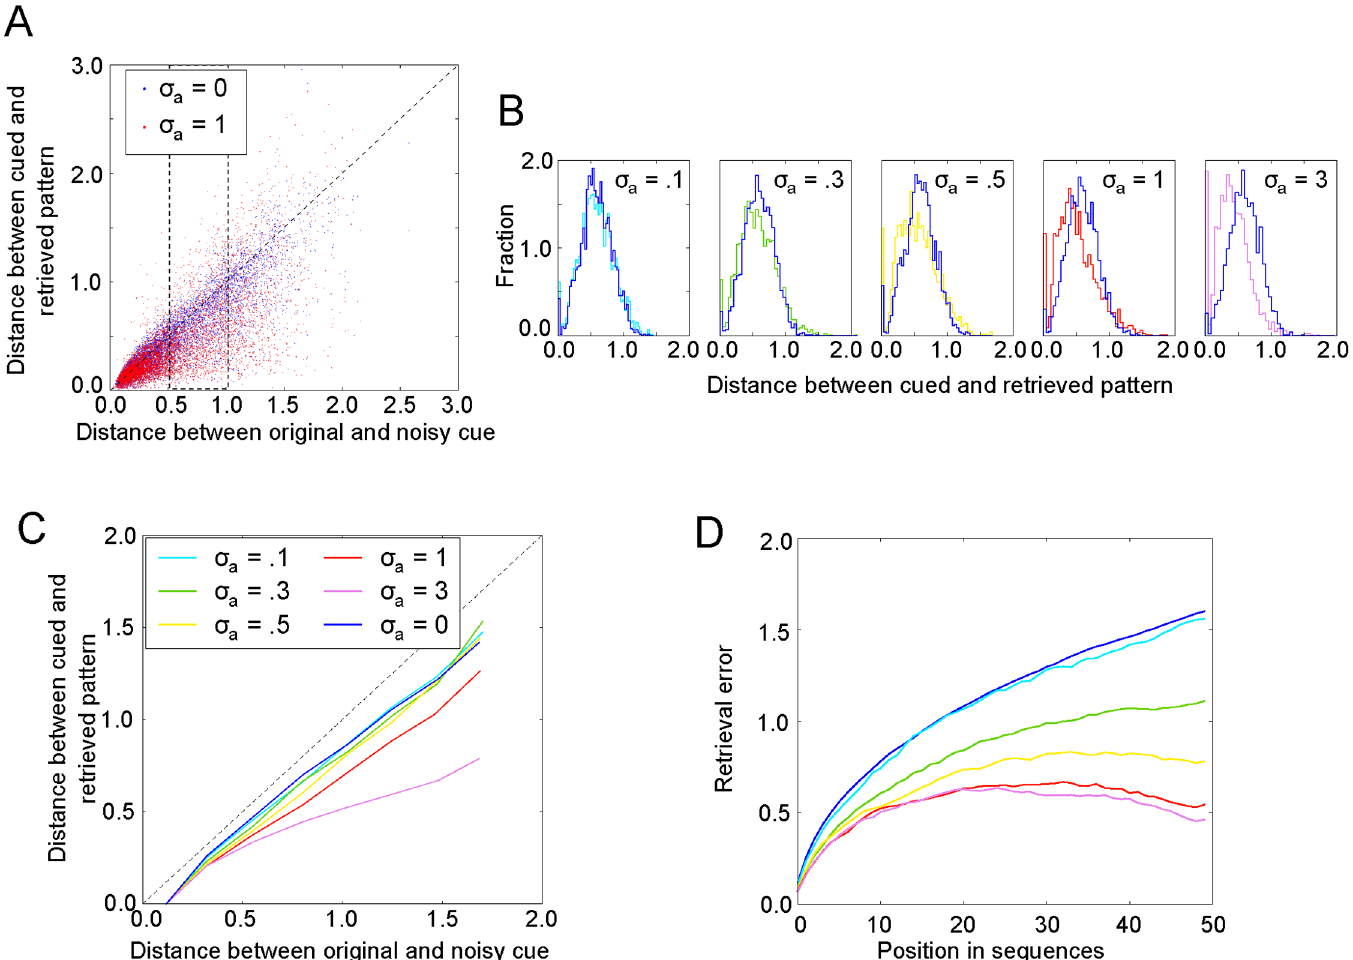
Fig 5. Pattern separation improves episodic memory retrieval. A: Example performance of single-pattern retrieval across different level of retrieval noise (raw data). B: Distribution of the distance between cued and retrieved patterns at different levels of pattern separation σ by different colors. The legend is given in panel C, the reference σ a = 0 is shown in dark blue. C: Average performance of single-pattern retrieval as a function of retrieval noise. D: Retrieval error for retrieval of sequences at different levels of σ